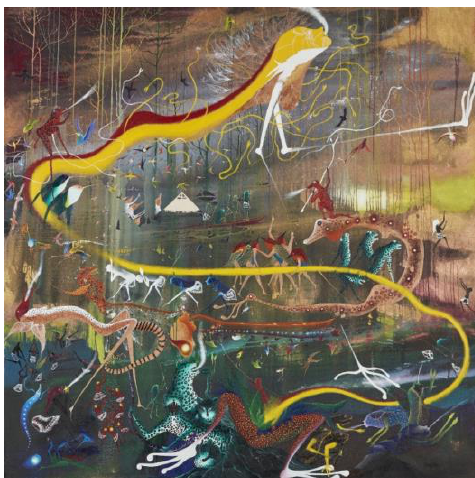
Figure 3. Rember Yahuarcani, Los primeros humanos conquistan a la mujer Arco Iris, la acomodan para que el cielo no caiga a la tierra, 2017, acrylic on canvas, 170 cm × 170 cm. Collection Museo Central—Banco Central de Reserva del Perú. Photo: Courtesy of Museo Central—Banco Central de Reserva del Perú.